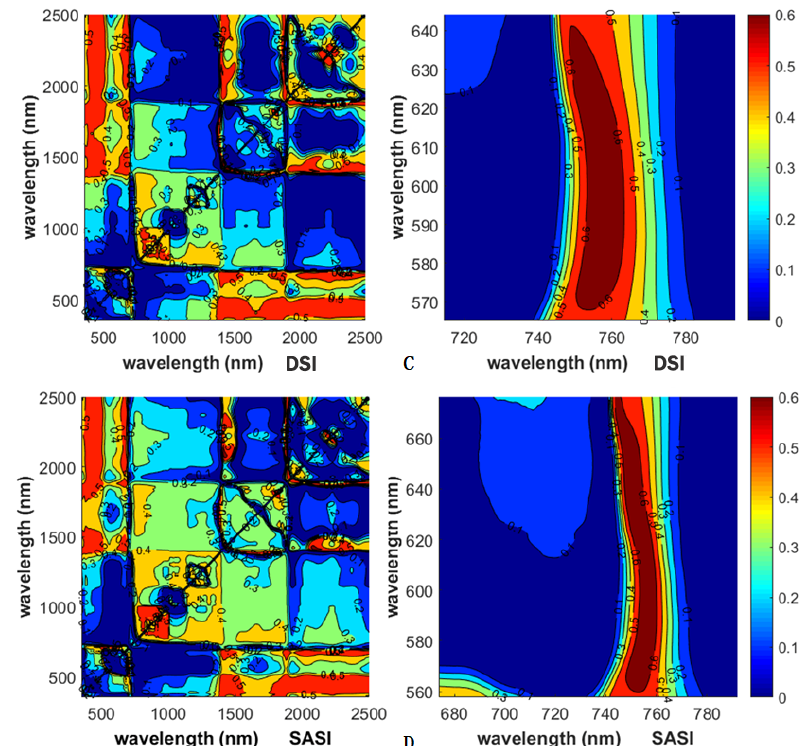
Figure 6. Pictures from A to D are contour maps of the coefficients of determination of the linear relationship between the vegetation indices NDSI, RSI, DSI, and SASI and the chlorophyll content of peanut leaves, respectively. (left) 10-nm sampling interval (right) 1-nm sampling interval.